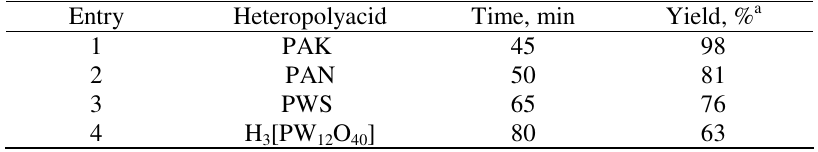
Table 3. Effect of supported heteropolyacids, on the yields of β -acetamido- β (4chlorophenyl) propiophenone, as optimized and model product under reflux condition